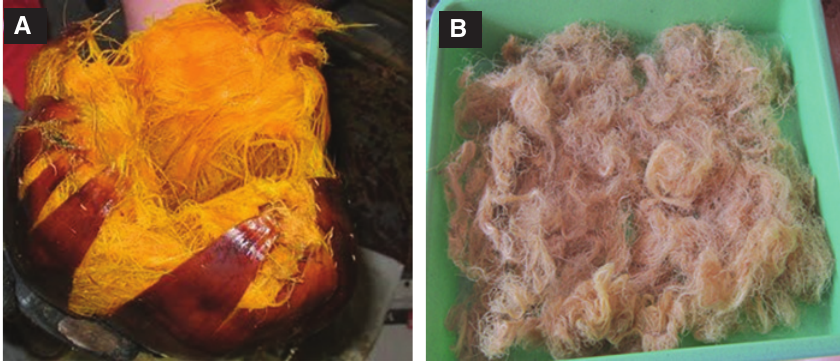
Figure 1 Photographic image of PF, fruit with fiber (A) and extracted fibers